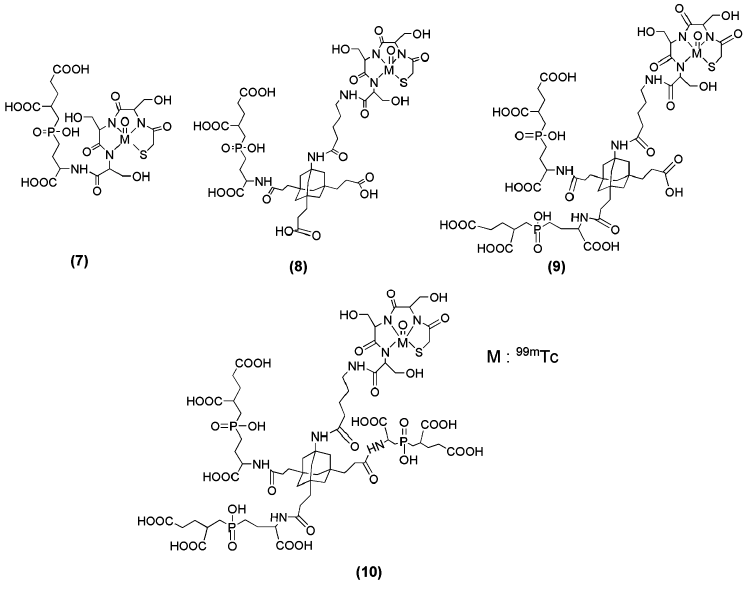
Figure 3. Chemical structures of the 99m Tc-labeled GPI ( 7 ) GPI monomer ( 8 ), GPI dimer ( 9 ) and GPI trimer ( 10 ) [72,73].